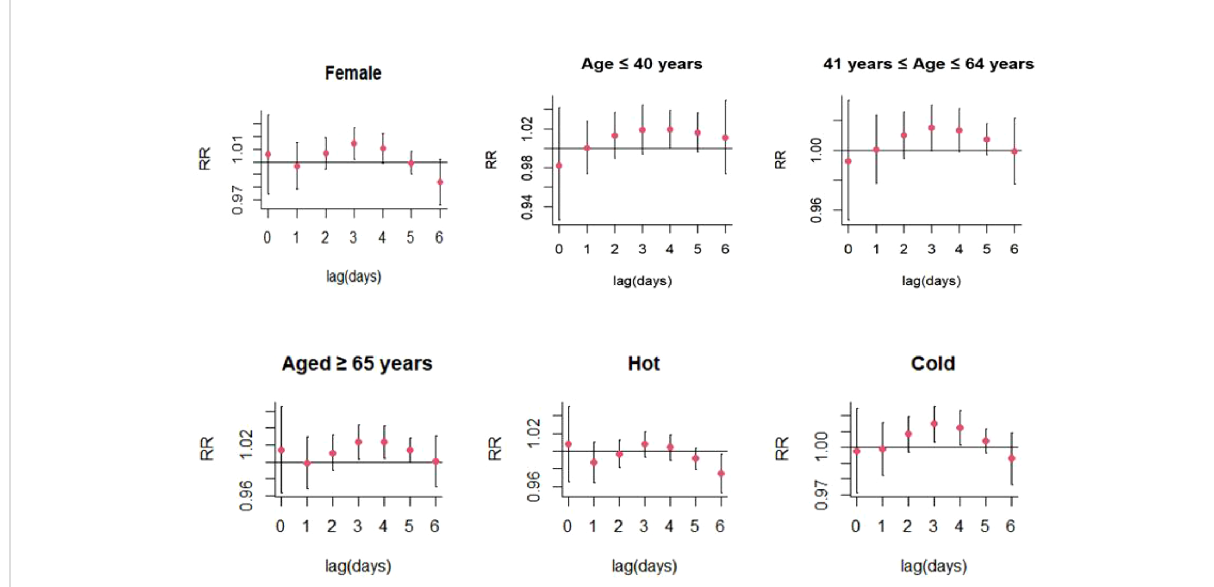
FIGURE 7 Lag-speci fi c relative risks (95% CI) of SS hospitalizations per 10 unit increase in the daily concentrations of PM 10 in model strati fi ed by age, gender, and season.